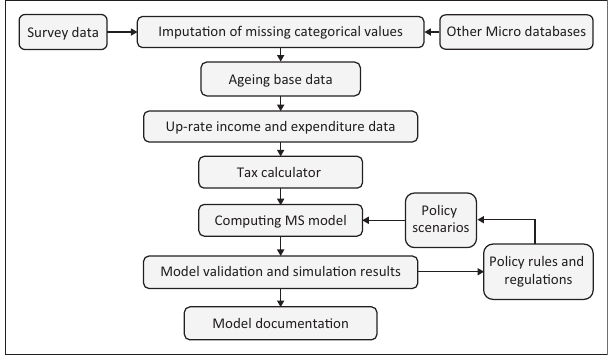
FIGURE 5: Structure of a micro-simulation